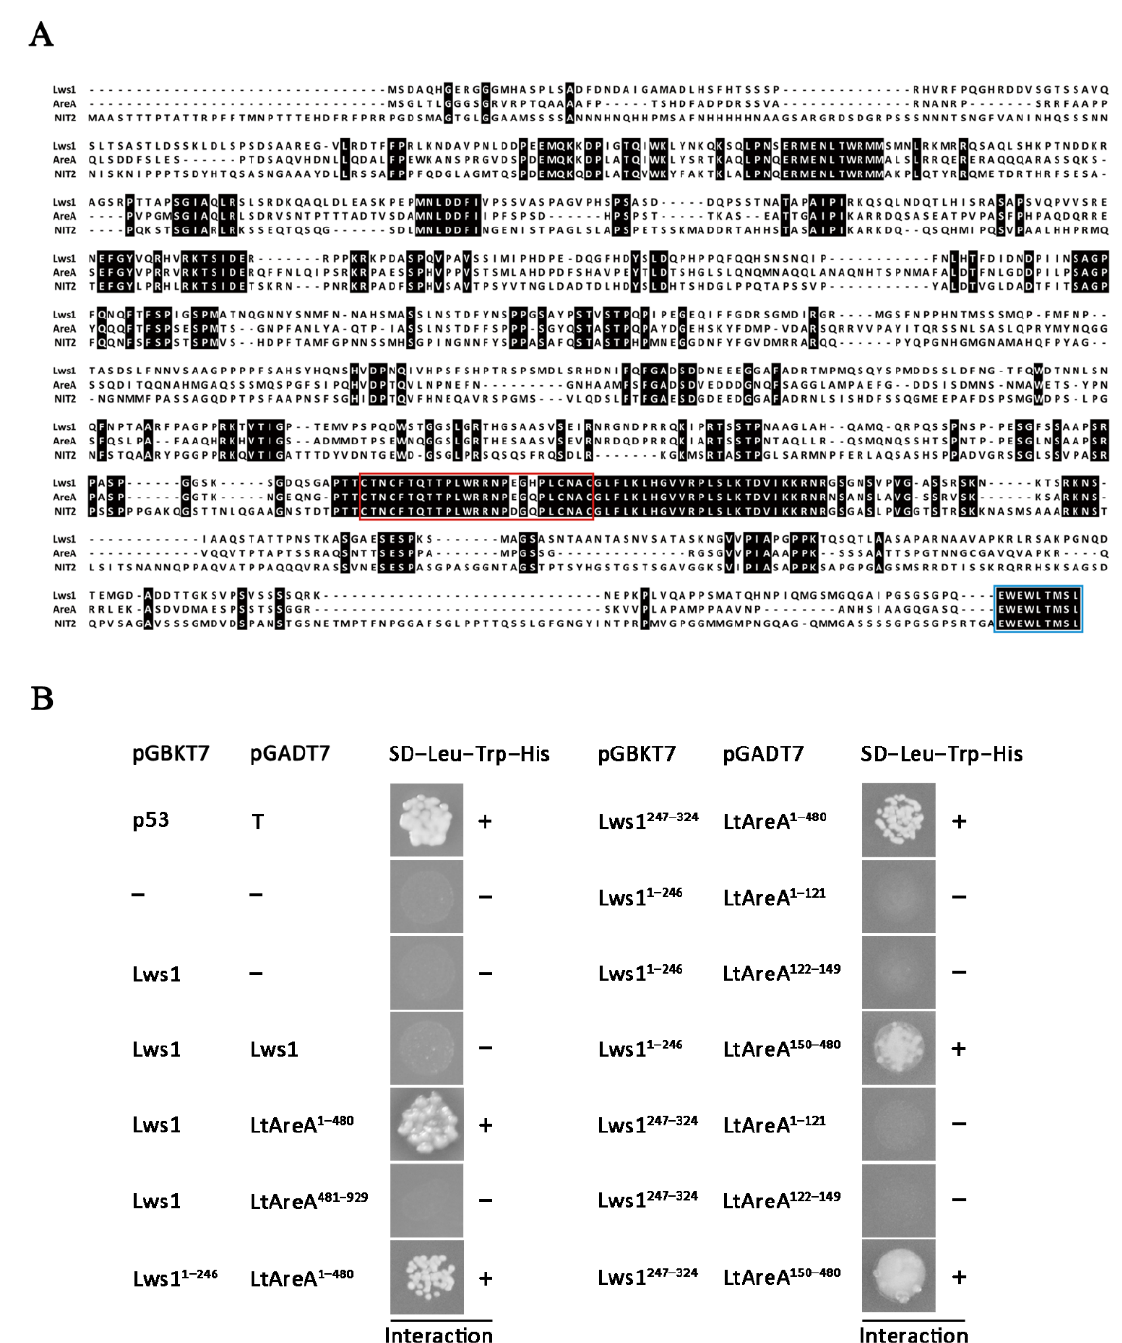
Figure 3. Interaction between Lws1 and LtAreA. ( A ) Multiple sequence alignments of AreA homologs from L. theobromae , A. nidulans , and N. crassa . Residues boxed in red denote the conserved C 2 C 2 motif. Residues boxed in blue signify the same motif in the extreme C-terminus. ( B ) The Lws1 cDNA or its truncated forms were cloned into the bait vector pGBKT7 , and the LtAreA cDNA or its trun- cated forms were cloned into the prey vector pGADT7 . Yeast cells expressing the prey and bait vec- tors were tested for their growth on synthetic dropout media (SD − Leu − Trp − His). Yeast trans- formants expressing the empty prey vector pGADT7 with the empty bait vector pGBKT7 or with the